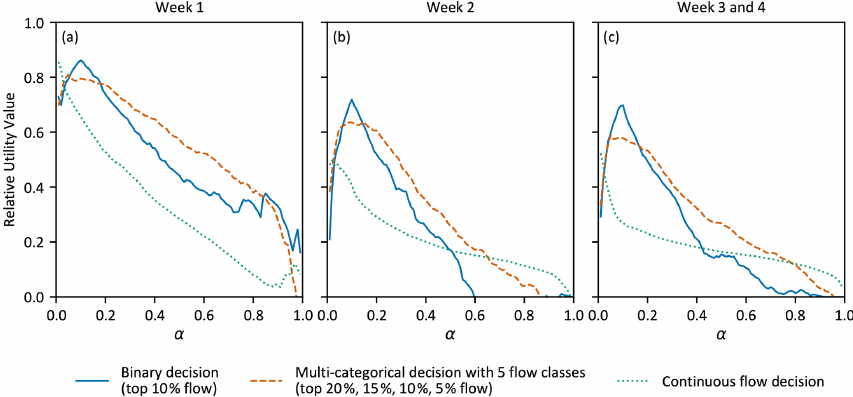
Figure 6. Forecast value for (a) binary decision of flow exceeding the top 10% of observations, (b) flow within five classes with thresholds at the top 20%, 15%, 10%, and 5% of observations, and (c) continuous-flow. Decisions are made using the optimisation approach for decision-making with a risk-neutral user, and subseasonal forecasts for the first, second, and combined third and fourth weeks of lead